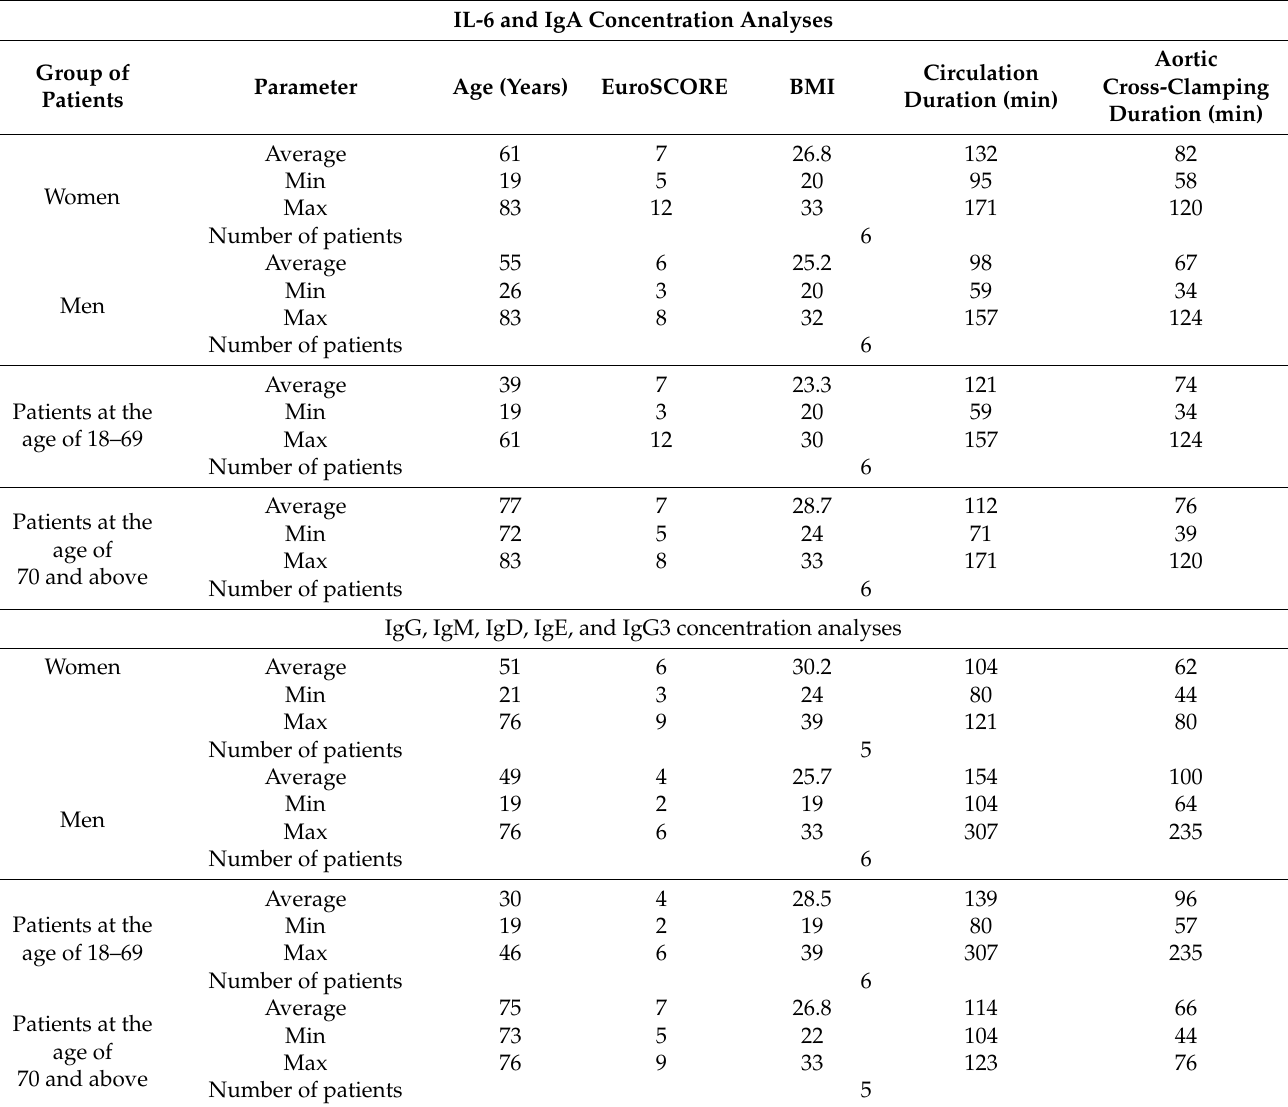
Table 1. Demographic data of patients selected for the analyses.